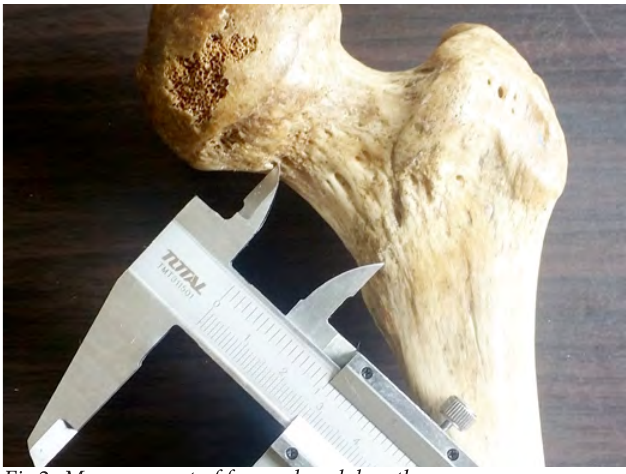
Fig 2 : Measurement of femoral neck length